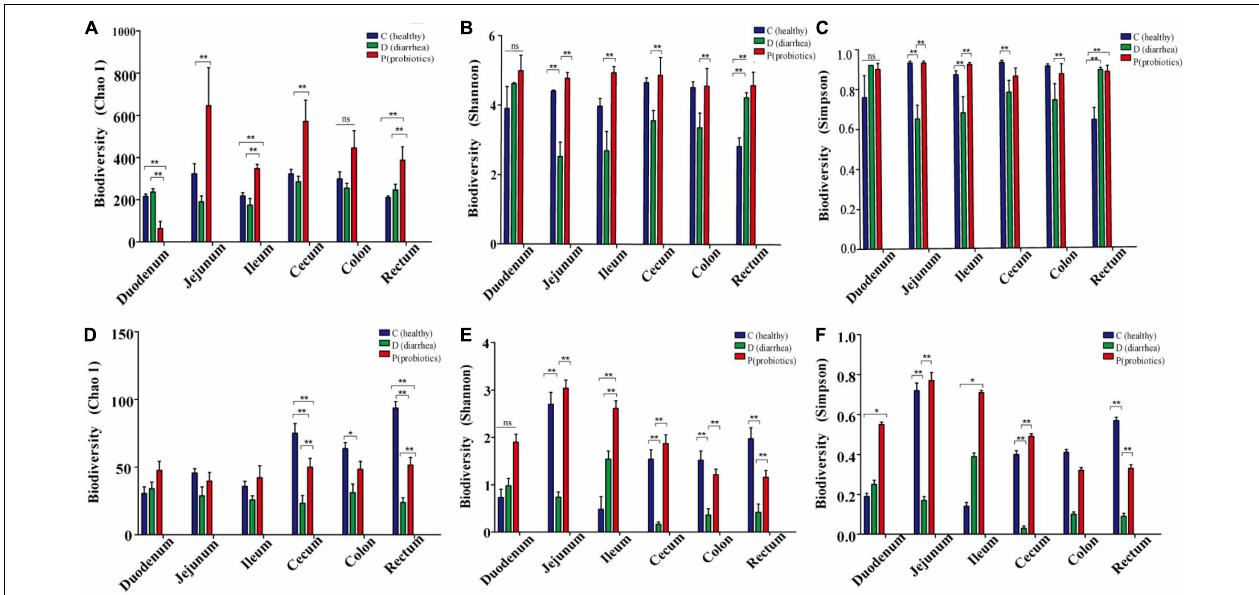
FIGURE 1 | The abundance and diversity index of microorganisms in different intestinal contents of Holstein calves. (A–F) Represent the abundance of Chao1, Shannon and Simpson and the diversity of bacterial and fungal microflora diversity indexes. * P < 0.05, ** P < 0.01.